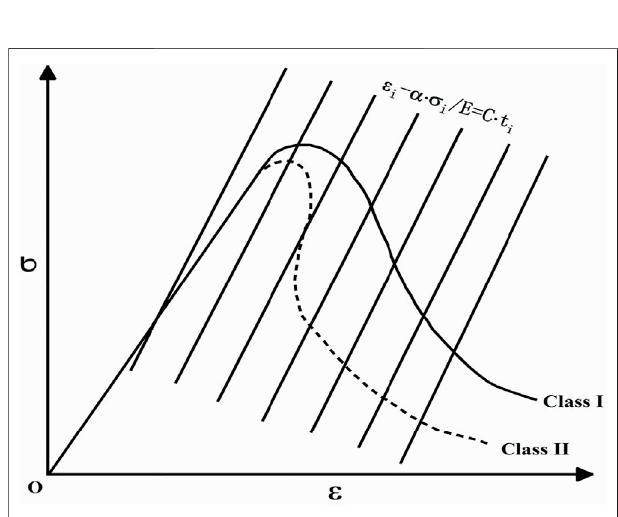
FIGURE 2 | Schematic diagram of control system and variable-resistance technology.